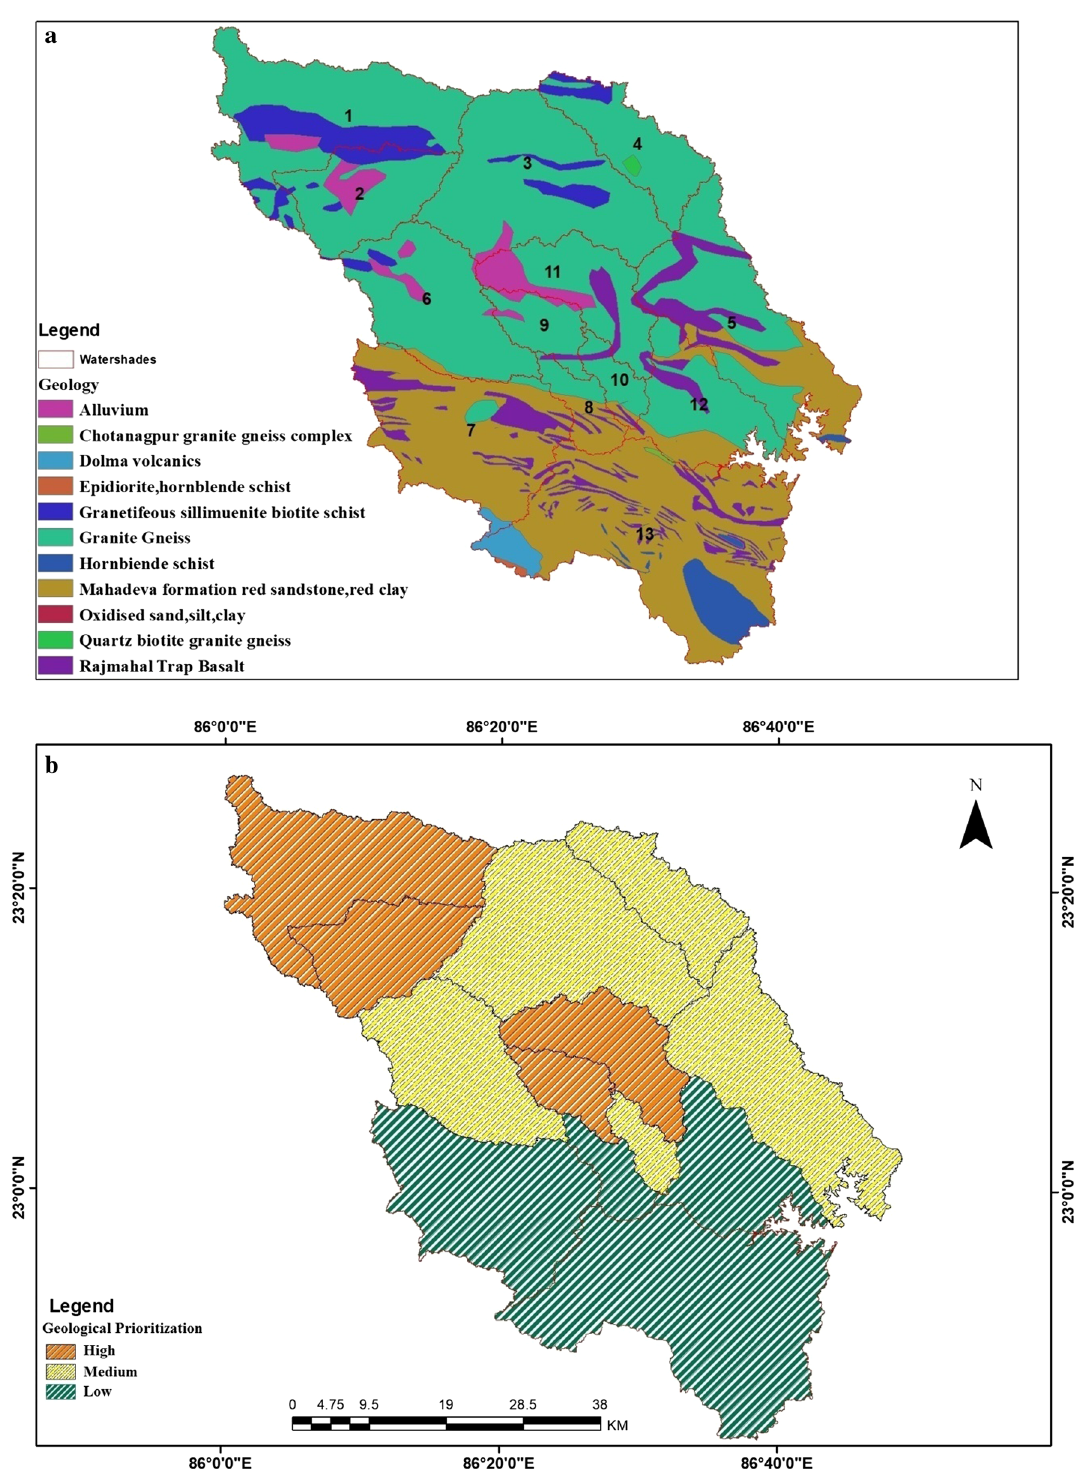
Fig. 4 a Geological set up in Kansai–Kumari reservoir catchment area and b priority based on geology in Kansai–Kumari reservoir catchment